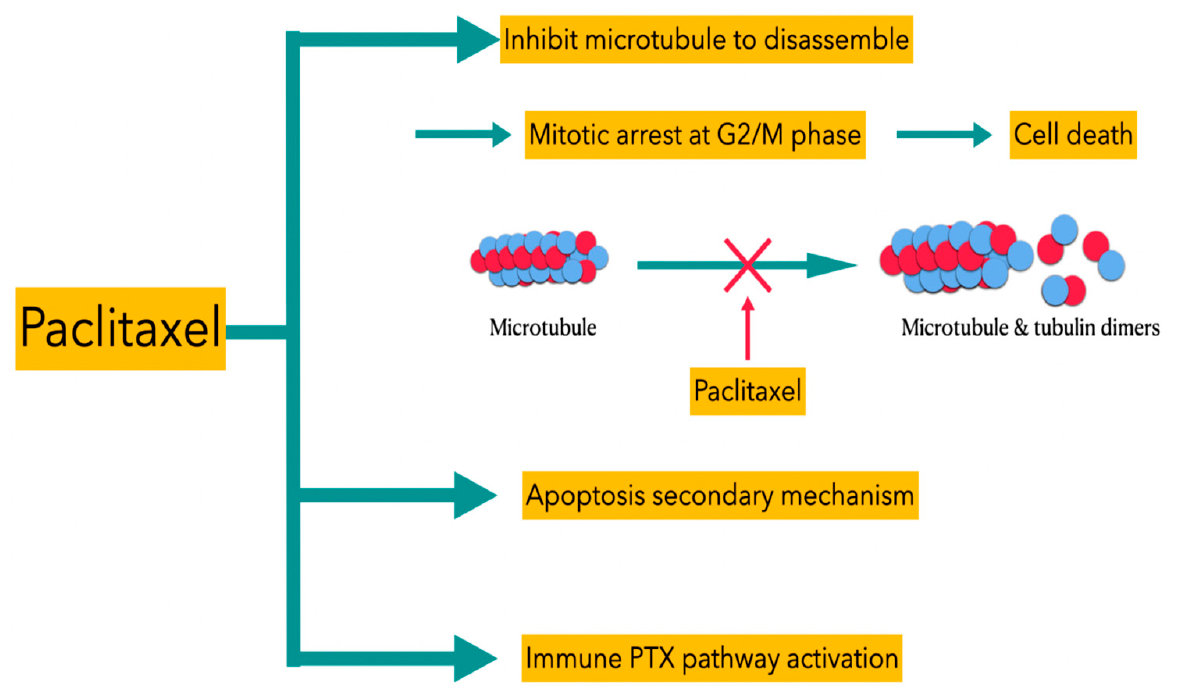
Figure 3. Different types of PTX pathways for inducing death of tumor cells.